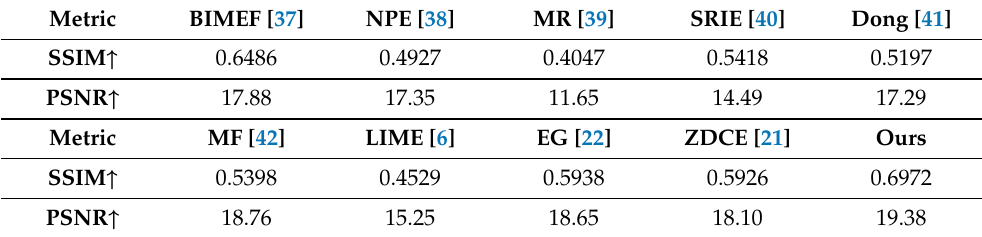
Table 3. Quantitative results in the LOL dataset: MR (MultiscaleRetinex), EG (EnlightenGAN), and ZDCE